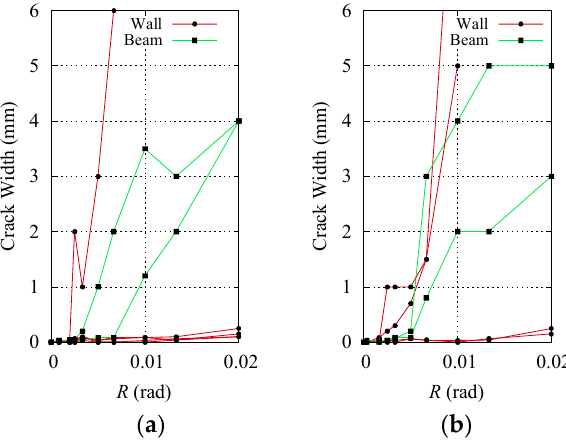
Figure 9. History of residual crack width: ( a ) BSH; ( b ) BS.